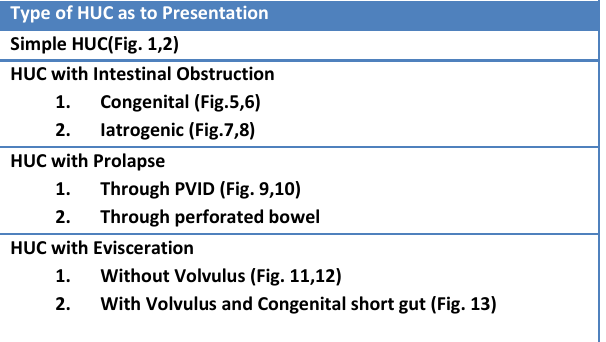
Table 1: HUC as to morphology and